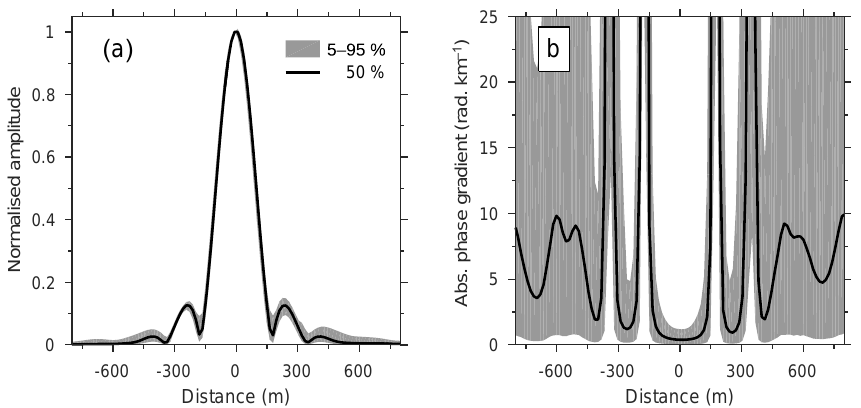
Figure 4. Impact of a single wind turbine on weather radar I/Q data, recorded by Vara during September 2016. Panel (a) shows the median normalised amplitude together with the 5th and 95th percentiles. Panel (b) shows the corresponding absolute phase gradient.